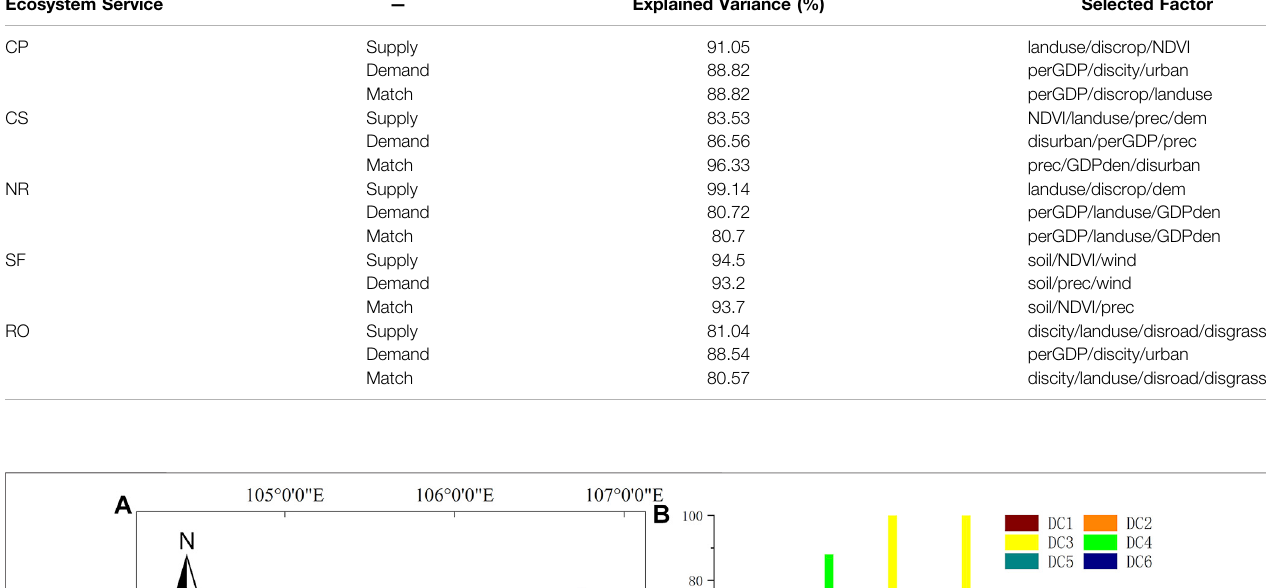
TABLE 6 | Selected socioecological factors for ES supply, demand, and match degree and their explained variances. Ecosystem Service